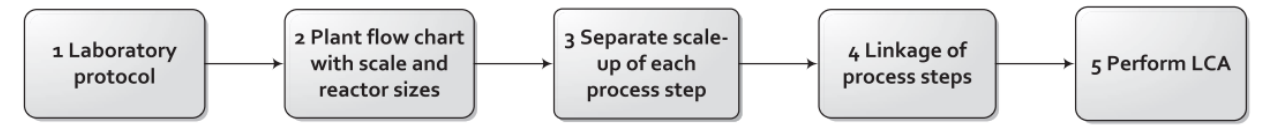
Figure 9. Scale-up framework overview (Reprinted from [60], with permission from Elsevier).